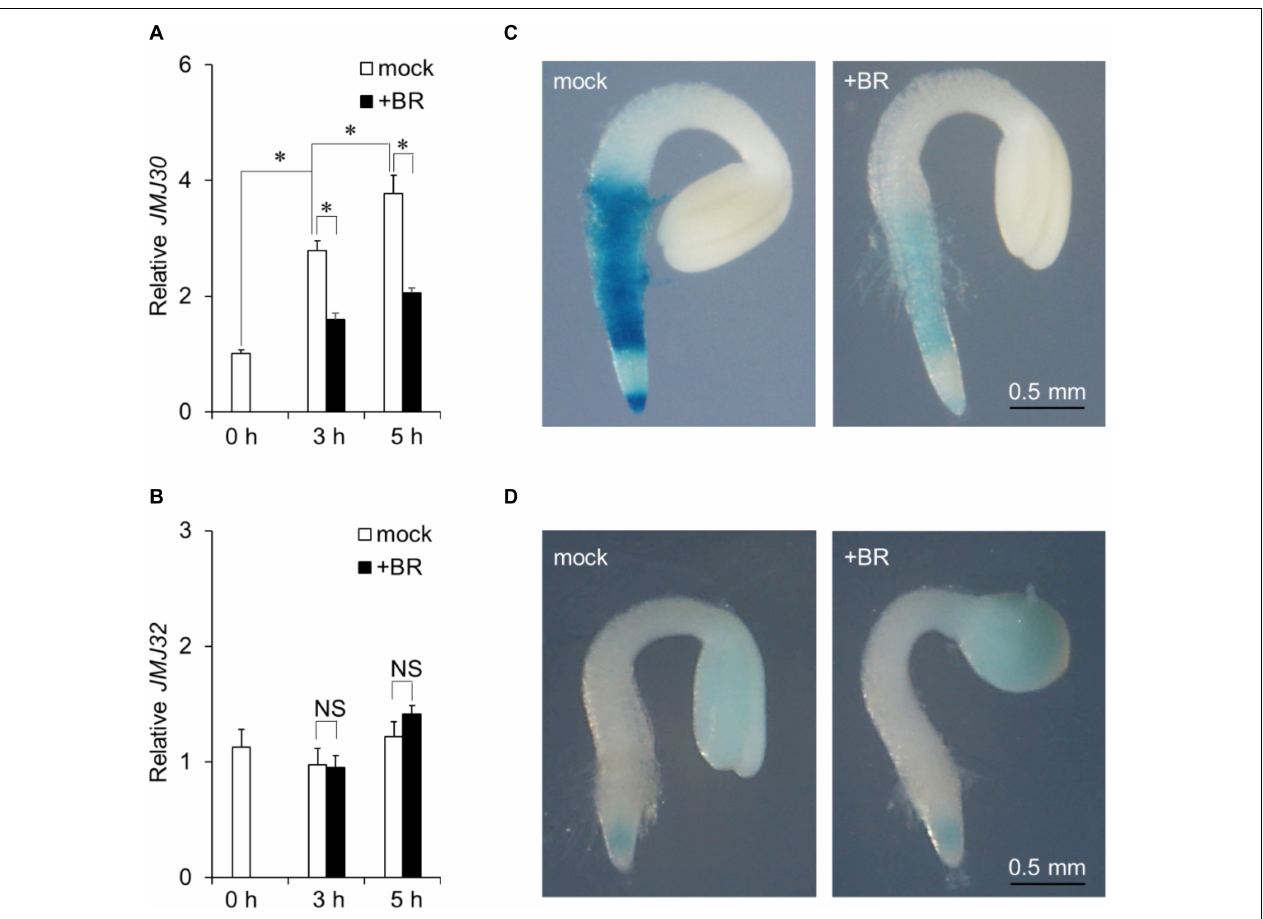
FIGURE 1 | Exogenous BR application suppresses JMJ30 upregulation during post-germination stage. (A,B) Expression of JMJ30 (A) and JMJ32 (B) based on RT-qPCR in wild-type seedlings in response to BR during post-germination stage. Data are from three independent experiments. Values represent means ± SEM. Asterisks indicate significant differences between two samples based on a two-tailed Student’s t -test. (C,D) pJMJ30:JMJ30-GUS (C) and pJMJ32:JMJ32-GUS (D) expression in wild-type background 5 h after mock or BR treatment. Scale bar = 0.5